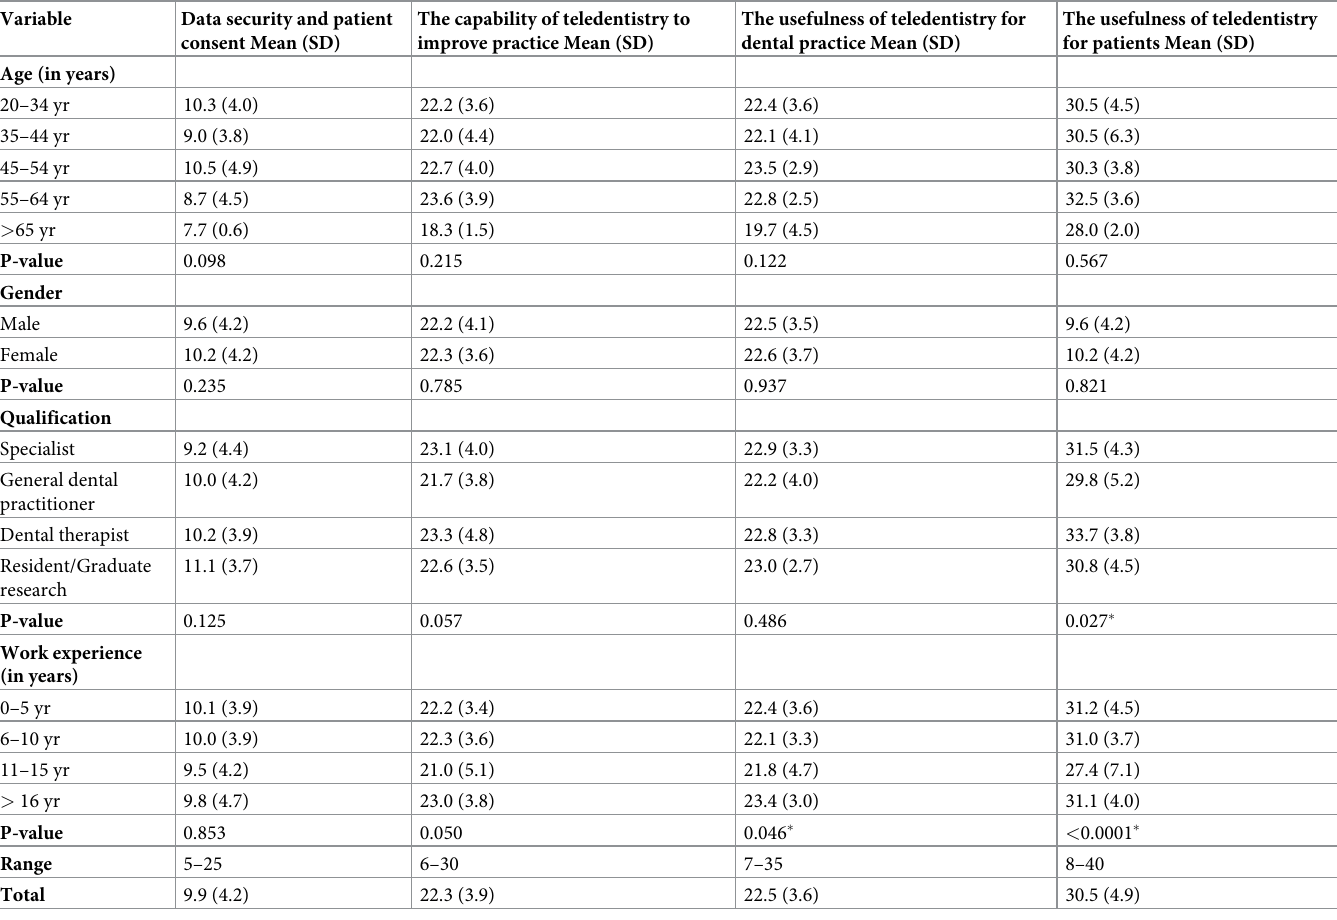
Table 4. Statistical significance between the demographic variables of the respondents with the four domains of Teledentistry (ANOVA test).